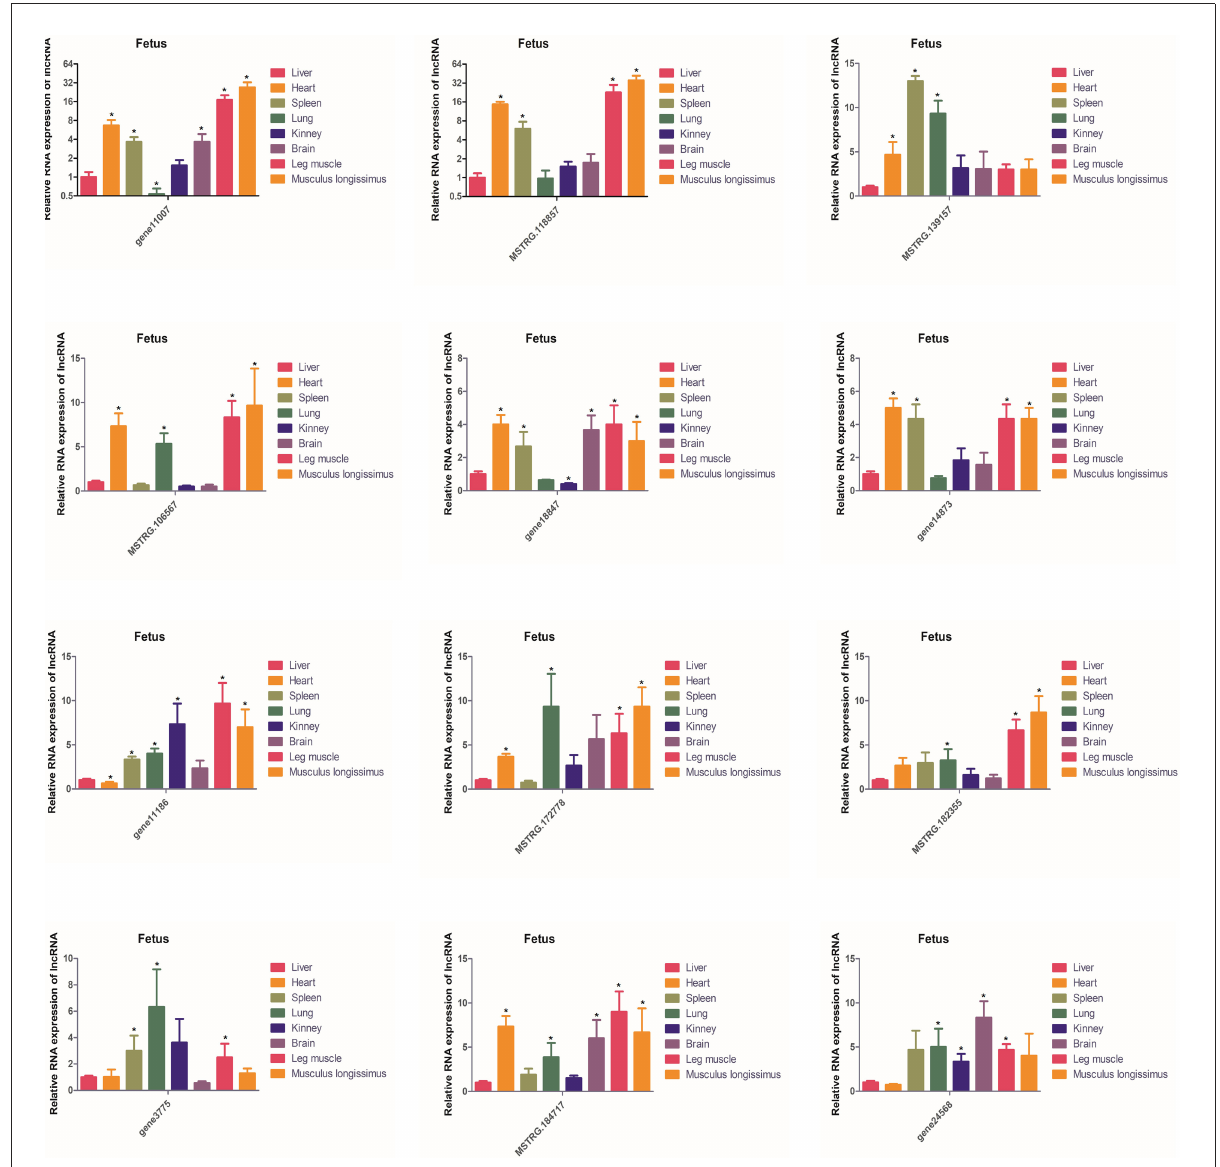
FIGURE6 Expression levels of 12 candidate lncRNAs in different tissues obtained from fetal buffaloes. The values are means ± SEMs for three individuals. *represents P <